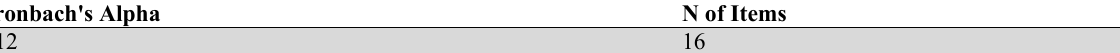
Table 2 indicates that the Cronbach's alpha stability factor has reached 0.712, which is an acceptable stability factor in such studies and indicates that the paragraphs were well prepared and validated by statistical methods, and the sample was randomly representative of the community. Hotel Size with (Product, Price, Place and Promotion) Star ratings